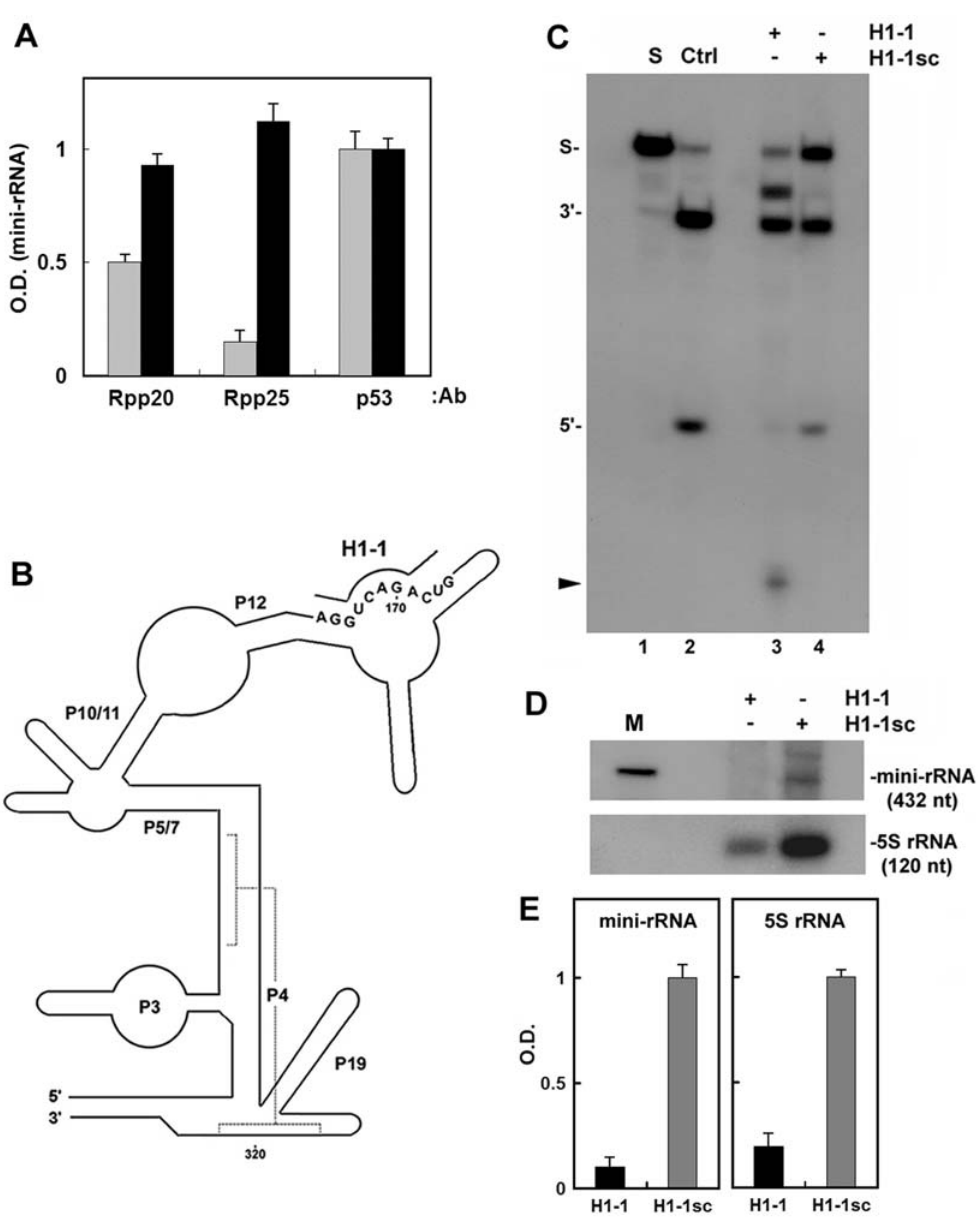
Figure 4. H1 RNA and protein subunits of RNase P are required for Pol I transcription in extracts. A. Whole HeLa extracts were subjected to immunodepletion analysis using 200 m L of serum containing polyclonal rabbit antibodies against Rpp20, Rpp25 or p53. Transcription reactions in the immunodepleted extracts (grey bars) or in extracts reconstituted with their corresponding immunoprecipitates (black bars) were carried out using the mini-rDNA gene and labeled RNAs were analyzed as described in Figure 1C. The 432-nt mini-rRNA band was quantitated and the optical density (in arbitrary units) was plotted. B. A proposed secondary structure of H1 RNA and the nucleotide sequence against which the antisense H1-1 deoxyoligonucleotide was directed. The upper half of H1 RNA represents the specificity domain. Conserved domains, including the P4 pseudoknot in the lower (catalytic) domain are shown. C. Whole HeLa extracts (15 mg/ml) were incubated with 8 m g of H1-1 (lane 3) or scrambled H1-1sc (lane 4) deoxyoligonucleotide in the presence of RNase H for 45 min as described [10]. Extracts were then assayed for RNase P activity in processing of 32 P- precursor tRNA Tyr , and cleavage products were analyzed in an 8% sequencing gel. The 5 9 leader sequence (5 9 ) and shorter species (arrow head) generated as a result of substrate miscleavage, are indicated. A concentrated DEAE-purified RNase P preparation (Ctrl; lane 2) was used as control for the correct cleavage of the substrate. D. Whole HeLa extracts described in C were subjected to transcription of the mini-rDNA gene and 5S rRNA genes as described in Figure 1C. E. Optical density of the mini-rRNA and 5S rRNA bands seen in panel